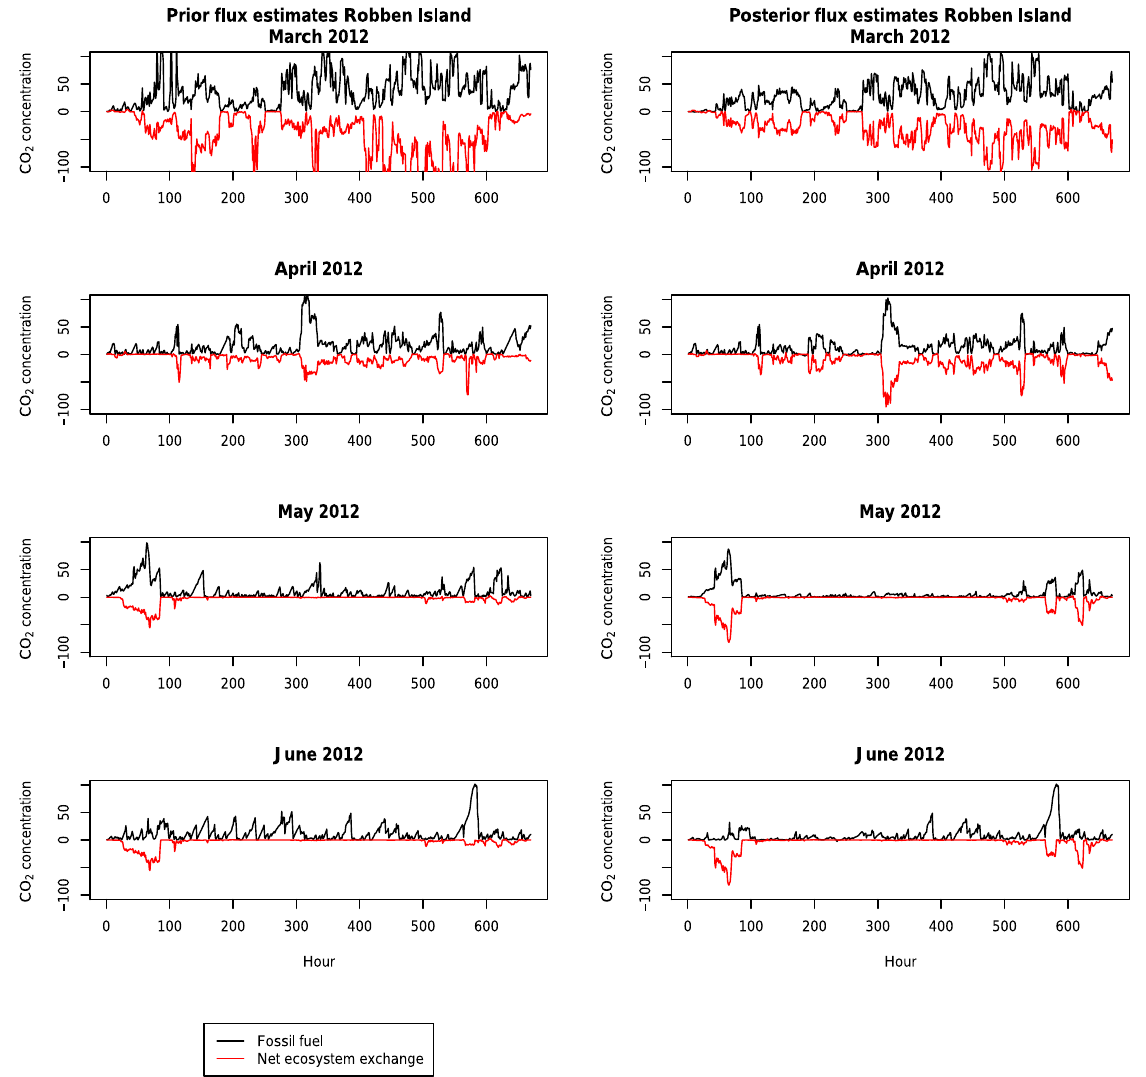
Figure 9. Prior and posterior contributions of the fossil fuel and NEE surface fluxes to the modelled CO 2 concentrations (ppm) at Robben Island from March 2012 until June